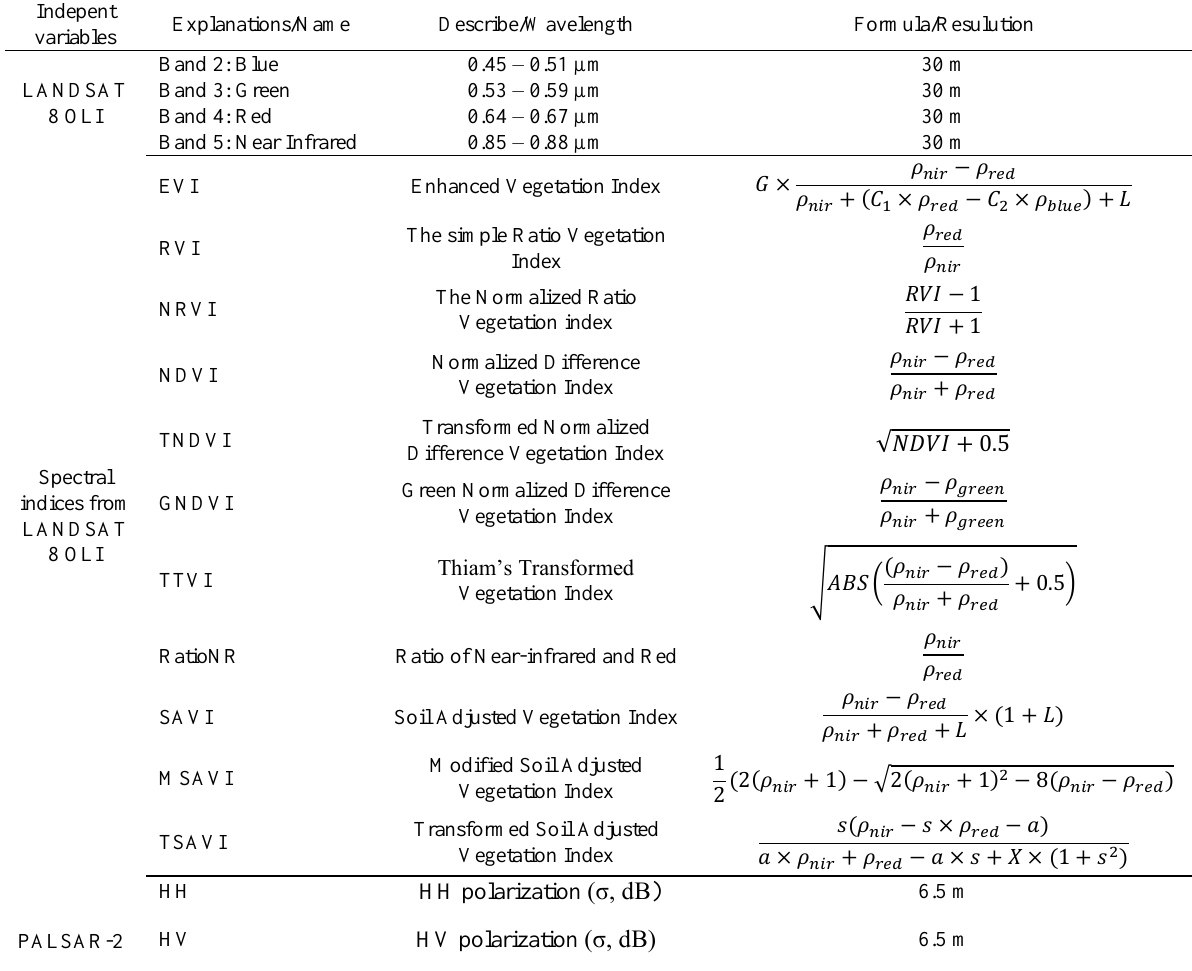
Table 1. Predictor variables from PALSAR-2 and LANDSAT 8 OLI used in this